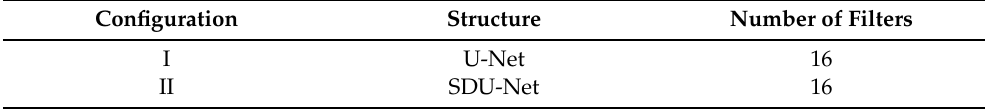
Table 4. Configurations of U-Nets for 3D